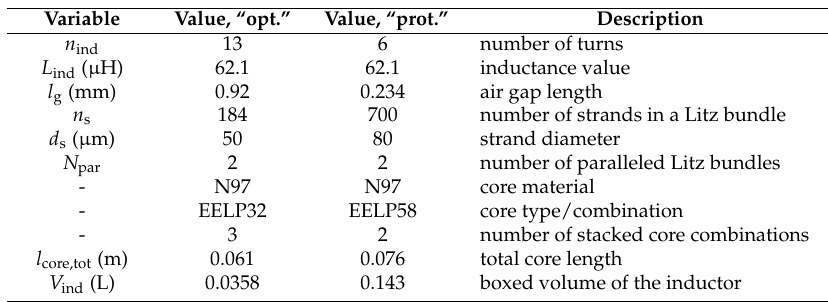
Table A8. Design values for the primary-side commutation inductor L 1 . Both the values for the “prot.” and the “opt.” design of L 1 are listed.